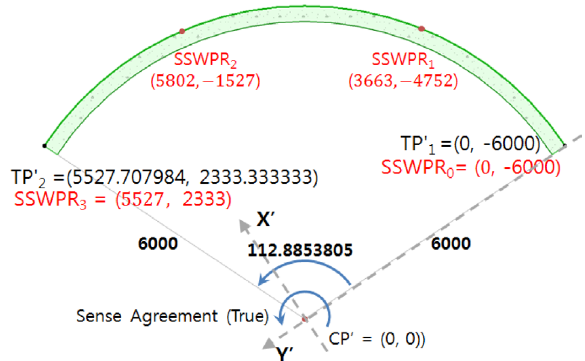
Fig. 13. Created SSWPR n